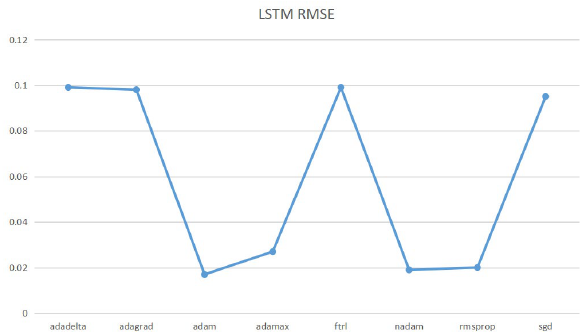
Fig. 5. Comparison of RMSE values whilst using different optimizers